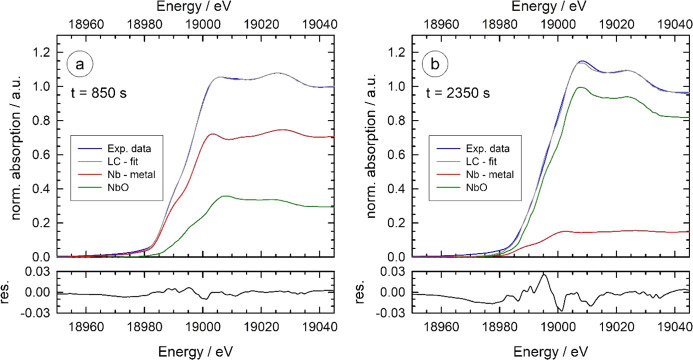
Examples of linear-combination fits using Nb metal and NbO for the modelling of the experimental XANES data. (a) t = 850 s, yielding 30.7 ± 0.3% NbO and 69.3 ± 0.3% of Nb metal. (b) t = 2350 s, with 85.6 ± 0.7% NbO and 14.4 ± 0.7% of Nb metal. In the lower panels, the difference between the experimental data and the fits are presented.